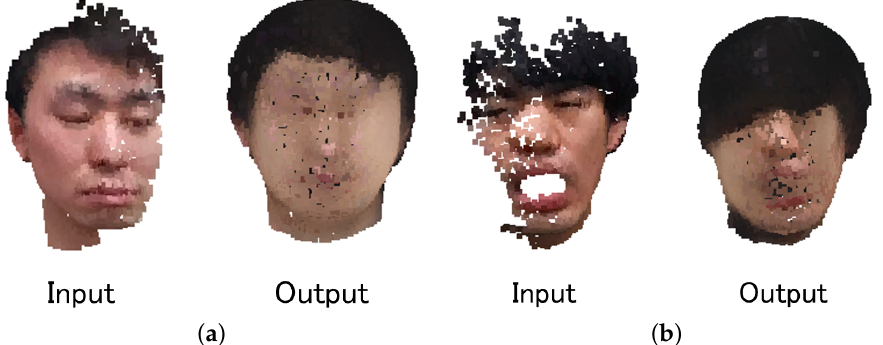
Figure 12. Results of completion the actual data using the trained proposed network with GAN. ( a ) Completion example 1; ( b ) Completion example